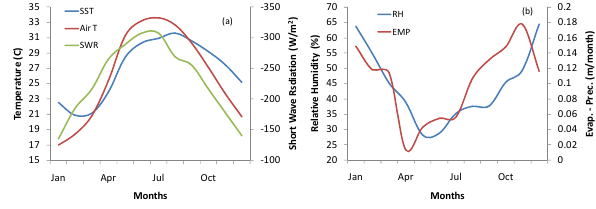
Fig. 2. Domain averaged time series of monthly: (a) Sea Surface Temperature, air temperature and upward short wave radiation, (b) relative humidity and calculated evaporation minus precipitation in 1992.